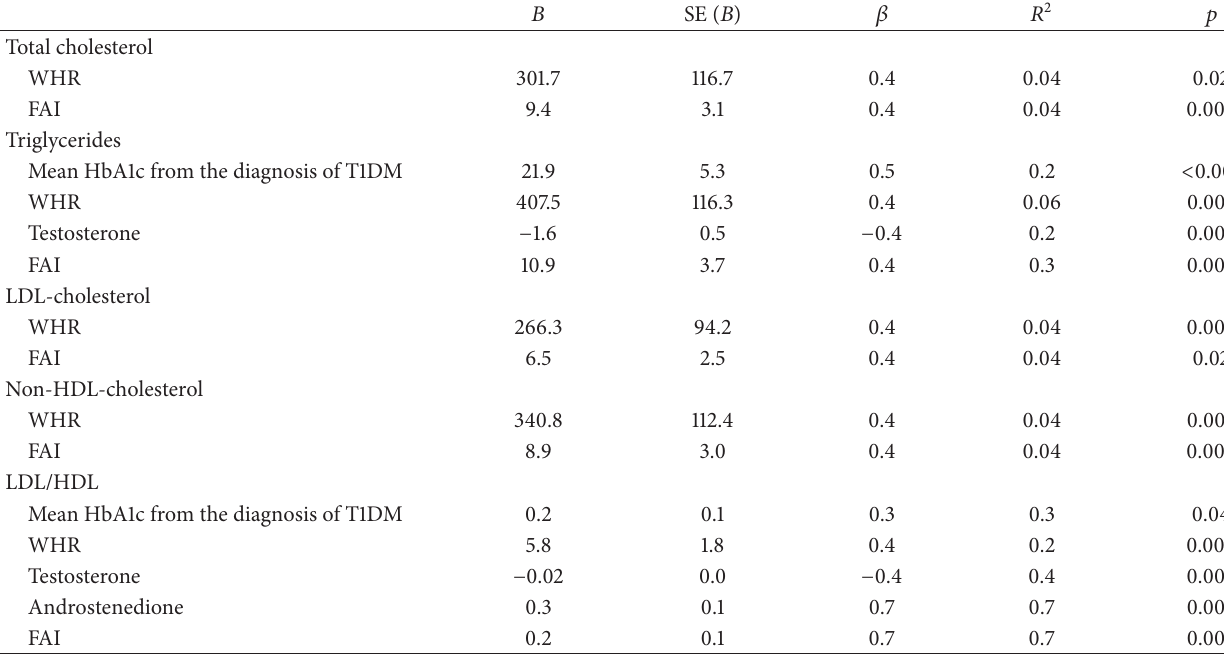
Table 3: Stepwise multiple linear regression models for lipids concentrations with respect to independent anthropometric, metabolic, and hormonal